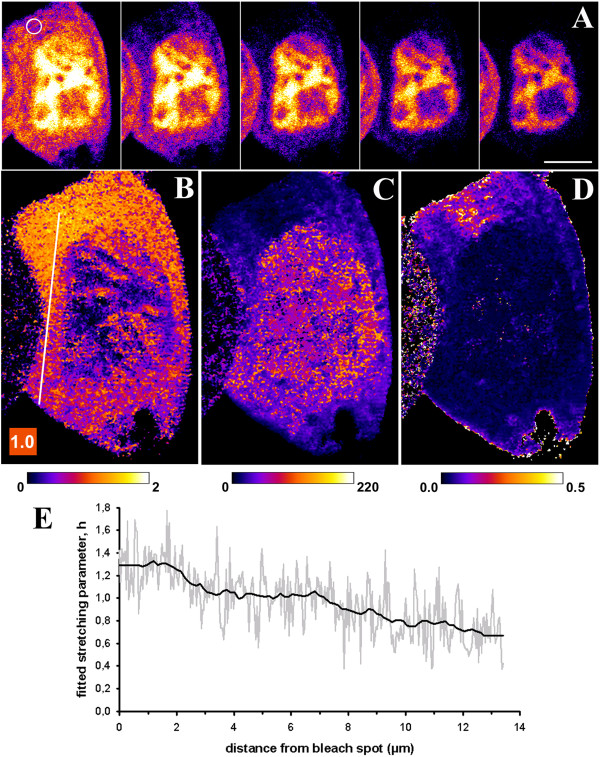
Diffusion-limited FLIP of eGFP in the cytoplasm of McA cells. McArdle RH7777 cells expressing eGFP in the cytoplasm and nucleus were placed on a temperature-controlled stage of a confocal microscope maintained at 35 ± 1°C. A 10 pixel diameter circular region in the cytoplasm (white circle) was repeatedly bleached with full laser power, while the whole field was scanned with 0.5% laser output between the bleach scans. This gave a total frame rate of 1.6 sec (see Methods for further details). A, montage of the time series with every 20th frame shown. B-D, fit of the StrExp function to the data giving a map of the stretching parameter (B), the time constant map (C) and its reciprocal, the rate constant map (D). A FIRE-LUT was used for color-coding, where dark blue and yellow indicate lowest and highest values, respectively. The range of values is given below the images with a color bar without units in B, in sec in C and in sec-1 in D. Bar, 5 μm. E, profile of stretching parameters along the line shown in B (grey line, data; black line moving average to smooth the profile).